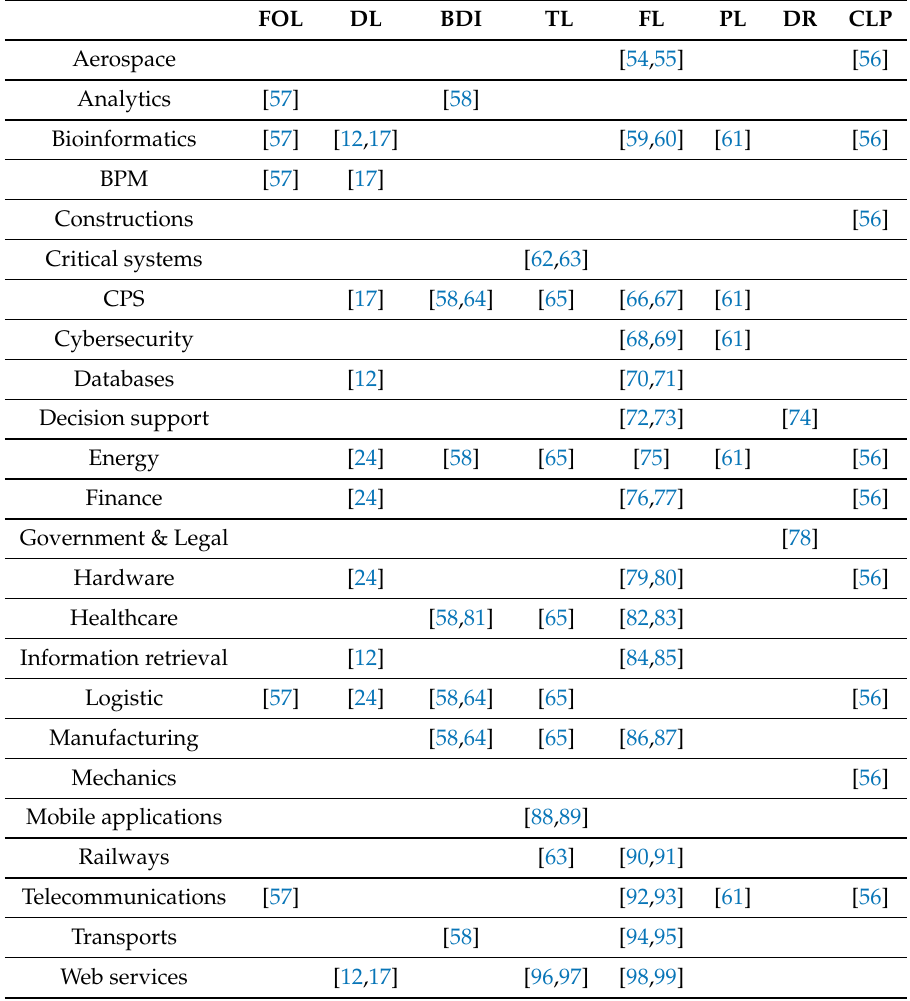
Table 2. Sorts of logic per market segment. Acronym and abbreviation key: FOL: First-Order Logic; DL: Description Logic; BDI: Belief-Desire-Intention (Logic); TL: Temporal Logic; PL: Probabilistic Logic; DR: Defeasible Reasoning; CLP: Constraint Logic